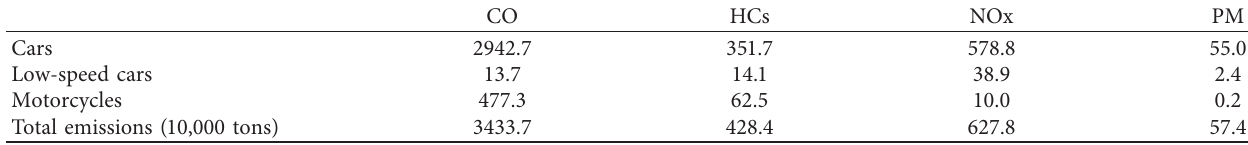
Table 1: Motor vehicle pollutant